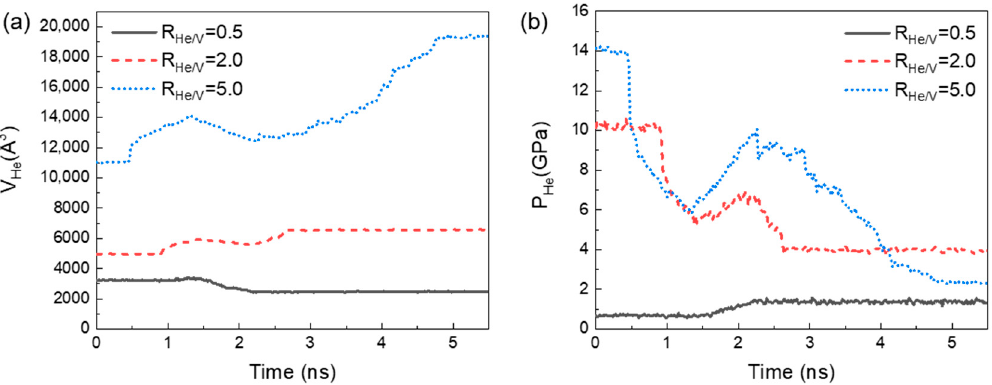
Figure 5. He bubble pressure and volume evolution with different R He/V at T 0 = 300 K and D 0 = 2 nm. ( a ) He bubble pressure; ( b ) He bubble volume.